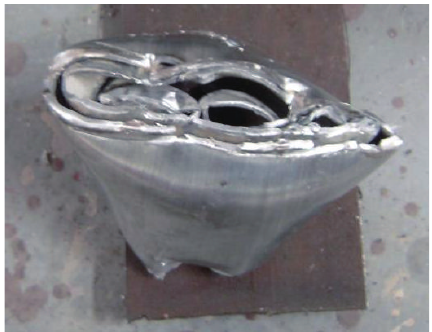
Figure 8: Tilt cutting edge.